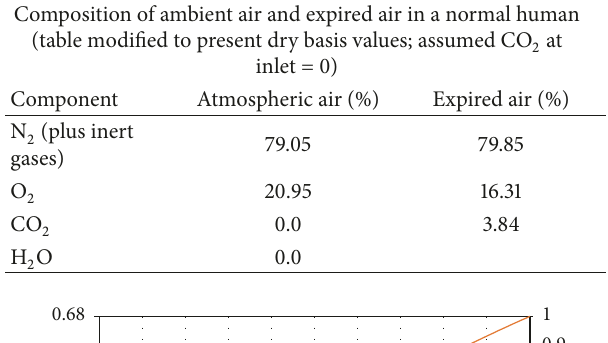
Table 5: Nasal gas analysis, adopted from Kimball, 2013 [34]. Composition of ambient air and expired air in a normal human (table modified to present dry basis values; assumed CO 2 at